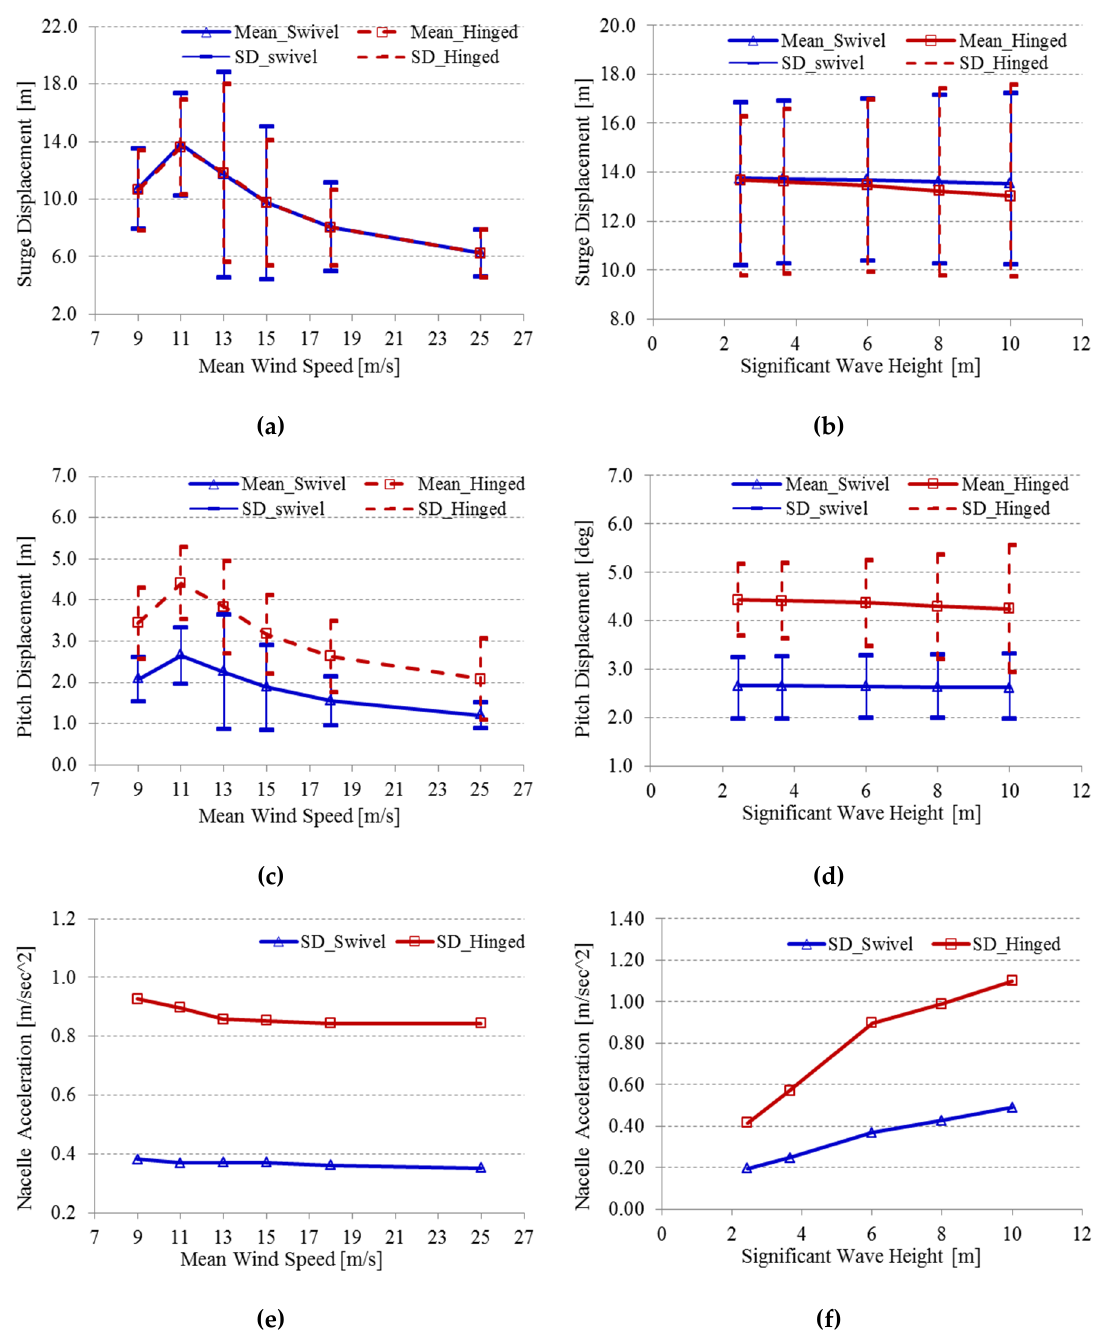
Figure 17. Surge/pitch motions and turbine performance with 300m water depth: ( a ) Surge motion V.S. Wind speed. ( b ) Surge motion V.S. Significant wave height. ( c ) Pitch motion V.S. Wind speed. ( d ) Pitch motion V.S. Significant wave height. ( e ) Nacelle acceleration V.S. Wind speed. ( f ) Nacelle acceleration V.S. Significant wave height. SD: standard deviation. Table 12. Standard deviations of the SWAY model for various water depths (U mean = 11.4 m/s).